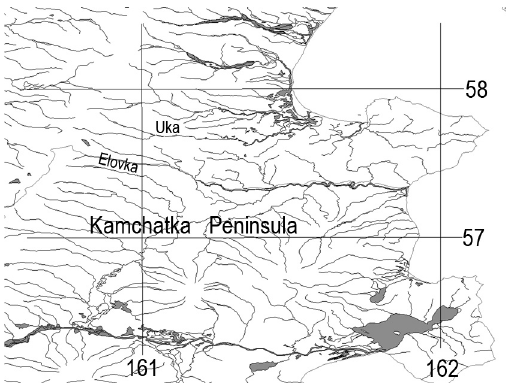
Fig. 20. Map of Southern Slope of Ulakhan-Tas Range calving grounds.